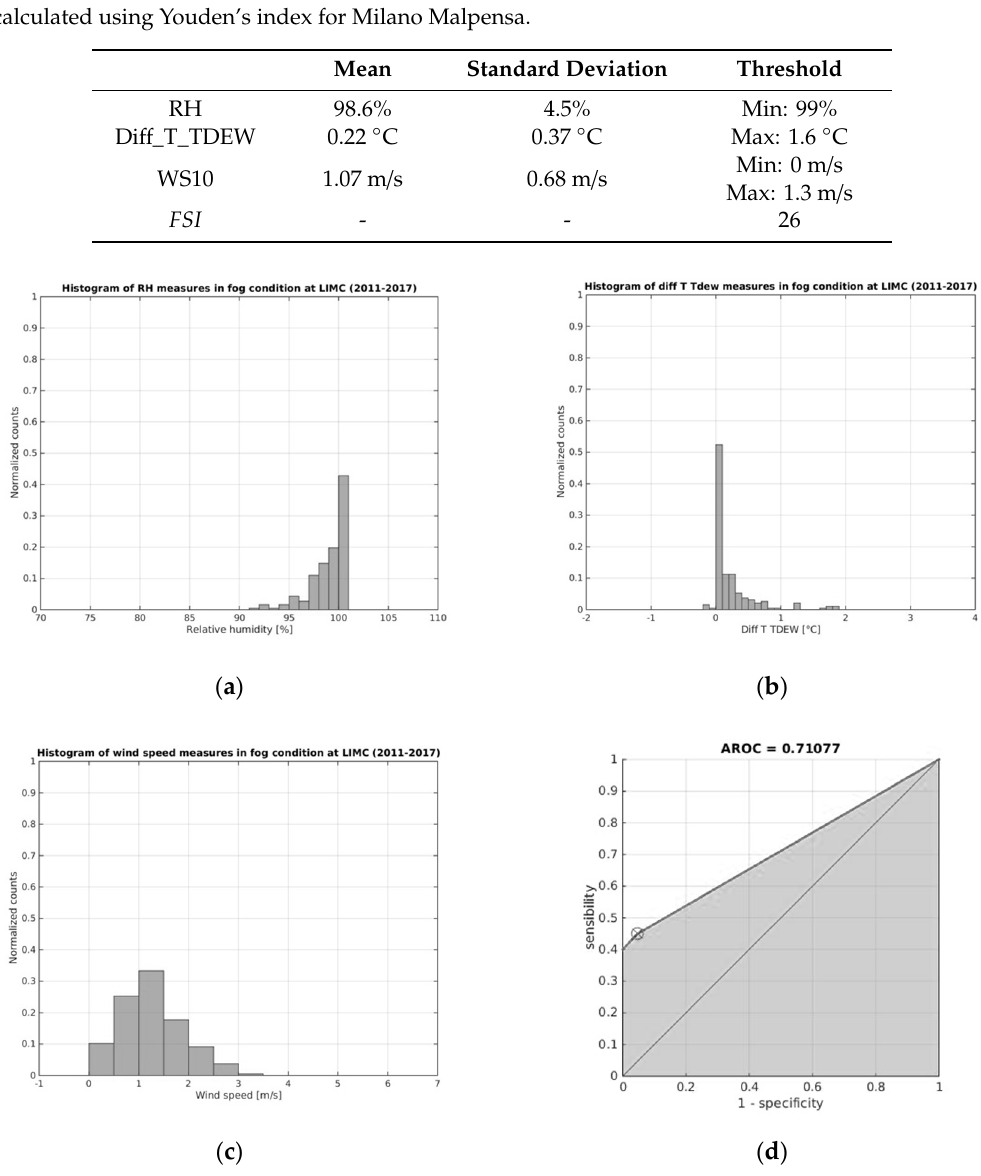
Figure 6. Histograms of the measurements of ( a ) relative humidity, ( b ) surface temperature / dew point difference, ( c ) wind speed in fog condition at Milano Malpensa in the period January 2011–December 2017 and ( d ) ROC curve with FSI_thresh = 26.